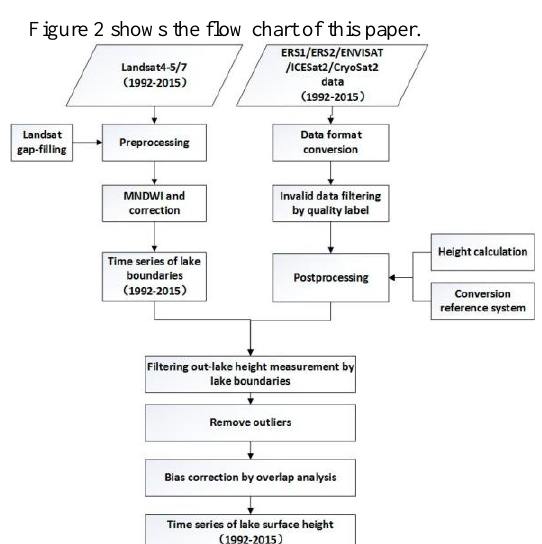
Figure 2. Framework for estimating the lake level variations by the use of multi-source imagery and multi-mission